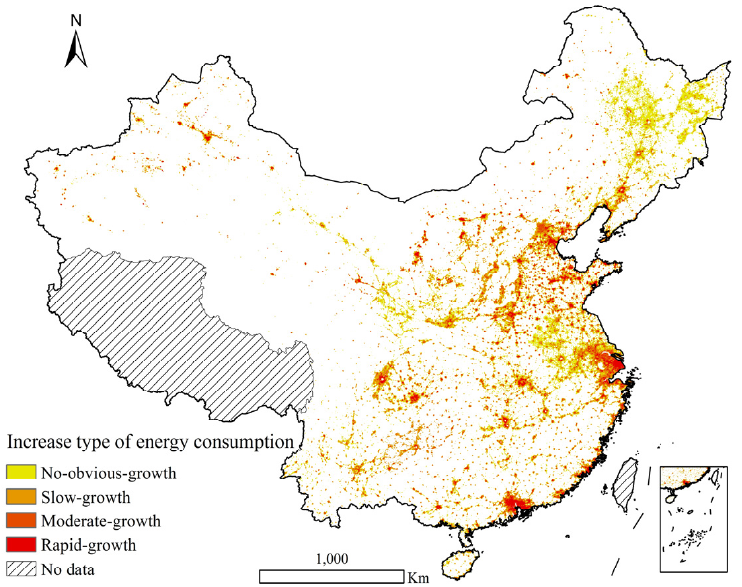
Figure 5. Four classes of the increments of energy consumption in China for 1995–2016 (Note: the non-positive growth was masked).